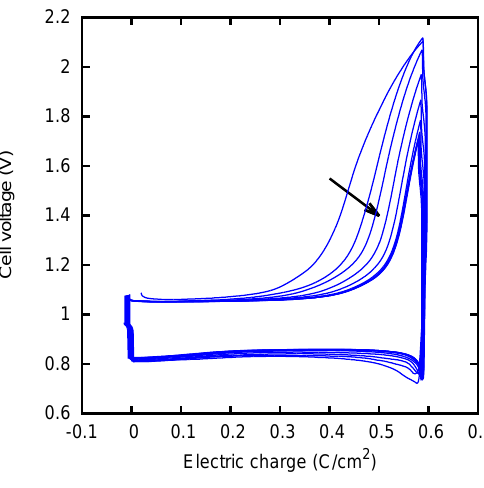
Figure 14. Charge–discharge cycles with the voltage increase at the end of the charge phase. The cycles are clockwise. The arrow shows the decrease of the peak with